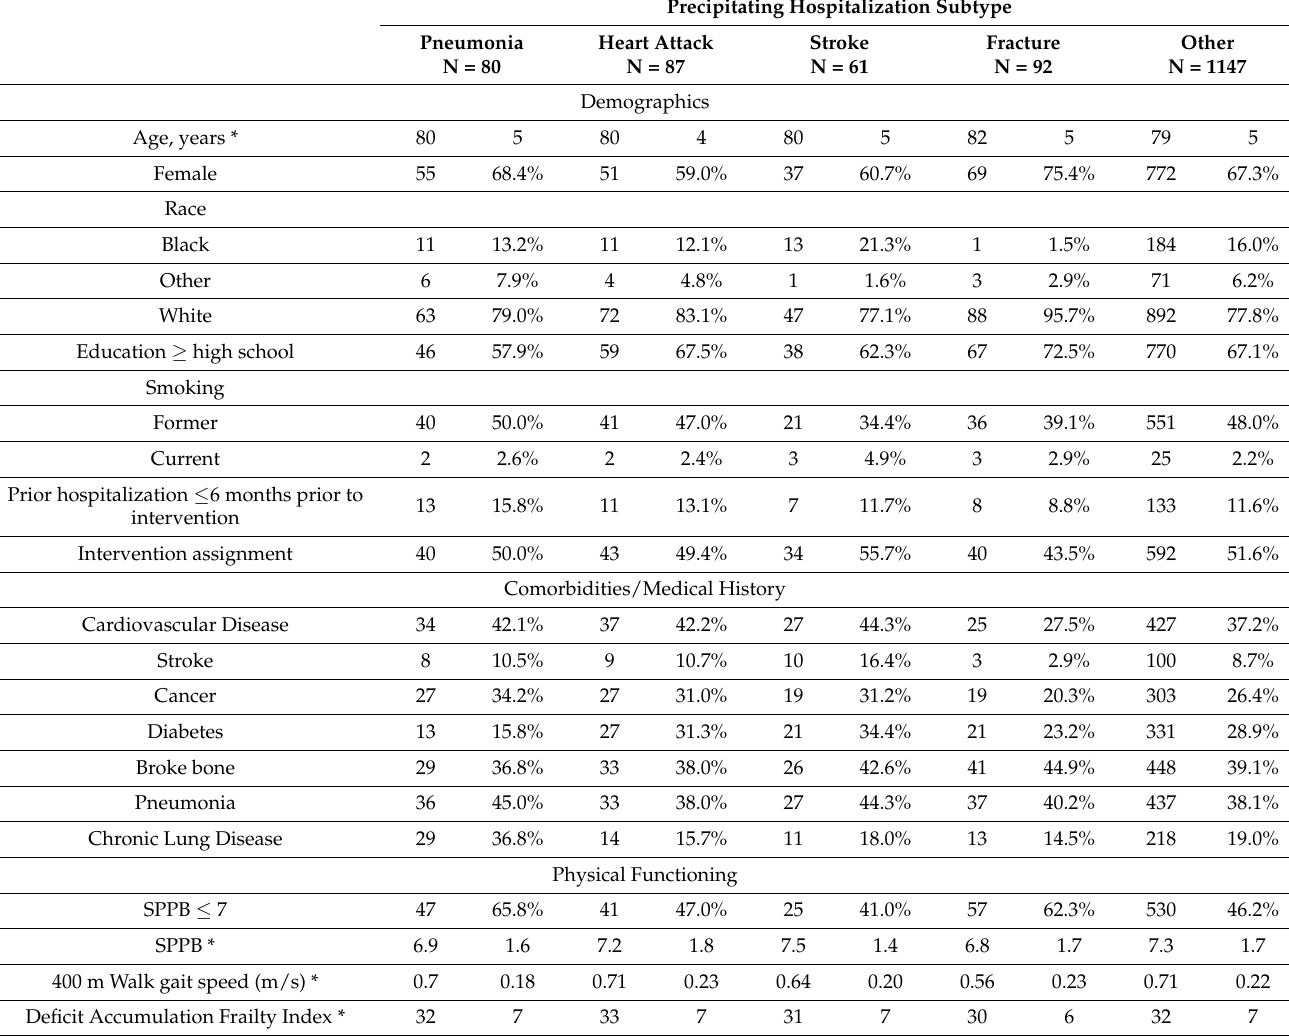
Table 1. Baseline demographics, medical history, and functional status of the LIFE Study cohort stratified by overall and by those with select acute hospitalization subtypes. All variables are reported as N and % unless otherwise (*) specified.